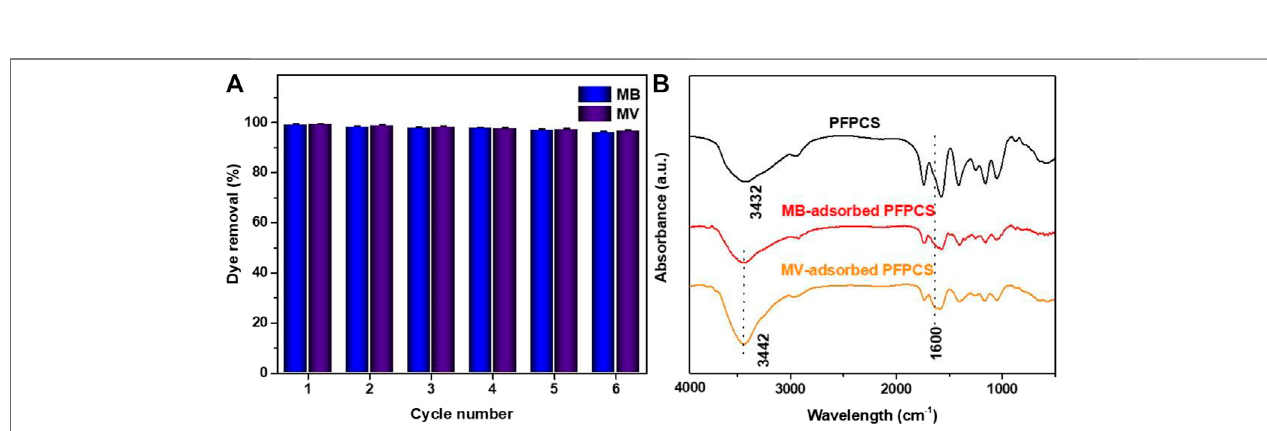
FIGURE 9 | (A) Removal rate of the PFPCS in six successive cycles of desorption-adsorption. (B) FTIR spectra of PFPCS before and after adsorption of MB and MV dyes.